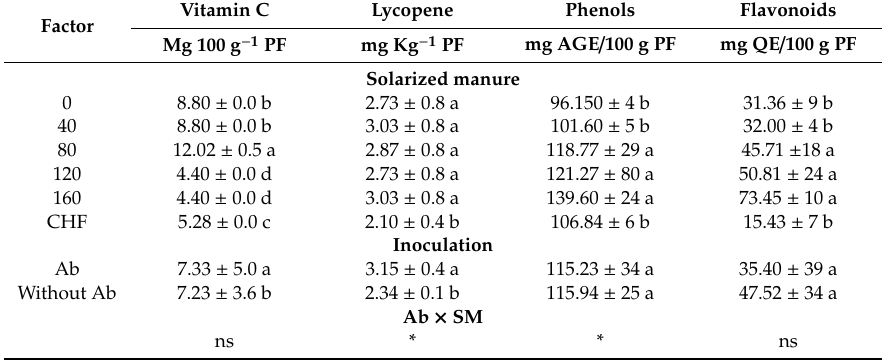
Table 6. E ff ect of Azospirillum brasilense (Ab), solarized manure, and interaction (Ab × SM) on vitamin C, lycopene, phenols and flavonoids in tomato fruits.